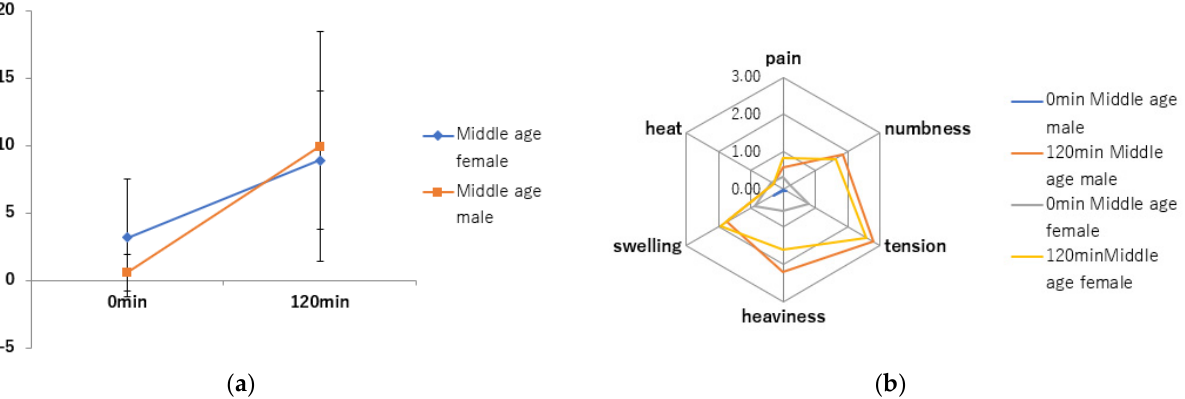
Figure 9. Lower leg symptom discomfort assessment . ( a ): calf discomfort points. ( b ): radar chart of six items of calf discomfort.